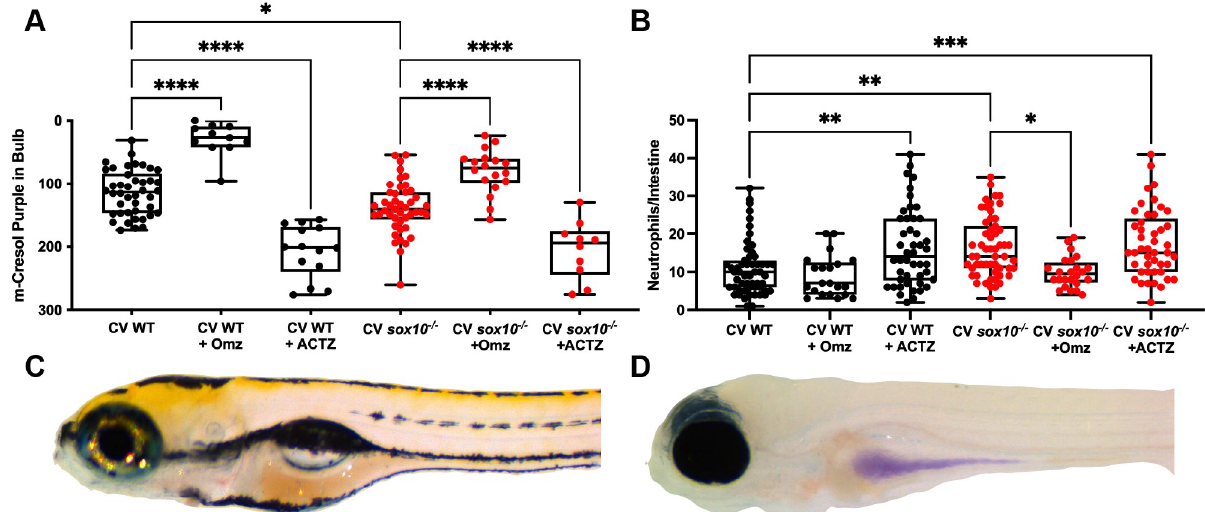
Fig 5. Decreased pH is necessary and sufficient for intestinal hyperinflammation. (A) Quantification of luminal pH in intestinal bulb plotting red + green–blue integer values (see Methods) of CV WT and sox10 mutants after 24 hour exposure to 200 μ M proton pump inhibitor omeprazole (Omz) or carbonic anhydrase inhibitor acetazolamide (ACTZ) 20 min after m-Cresol Purple gavage. (B) Quantification of intestinal neutrophil number per distal intestine in CV WT and sox10 mutants after 24 hour exposure to 200 μ M Omz or ACTZ. (C) Representative images of WT after ACTZ treatment and (D) sox10 mutant after Omz treatment. In A & B, each dot is a fish, n > 10. Boxes represent the first to third quartiles, center bar denotes the median, and whiskers the maximum and minimum of each dataset. � p < 0.05, �� p < 0.01, ���� p < 00001. ANOVA followed by Tukey’s post hoc